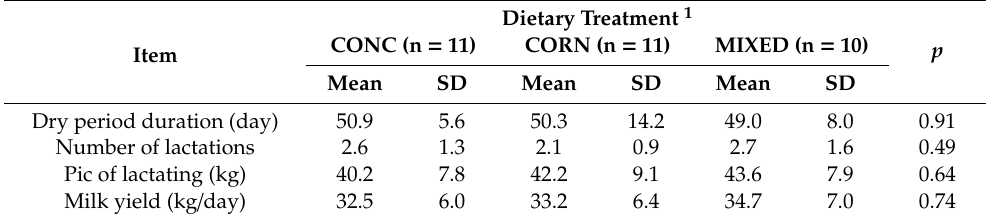
Table 2. Description of the groups of cows which have received three dietary treatments given during the dry